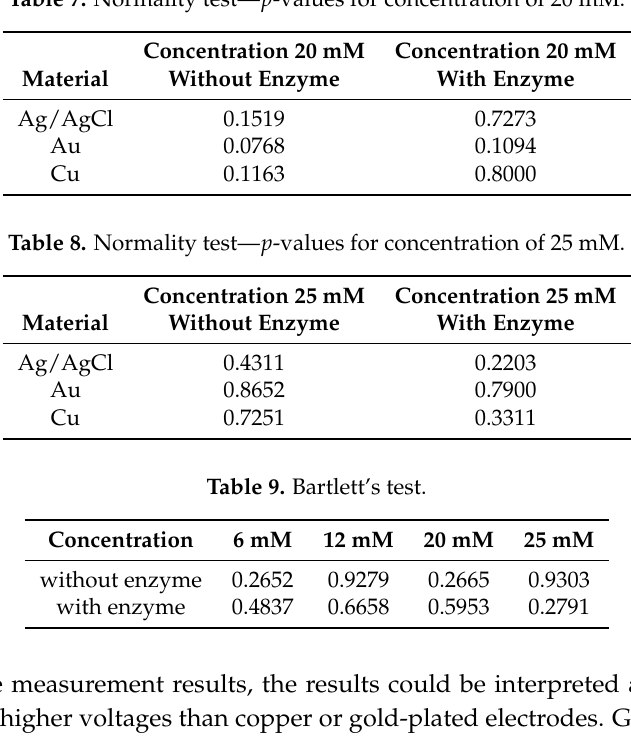
Table 7. Normality test— p -values for concentration of 20 mM.